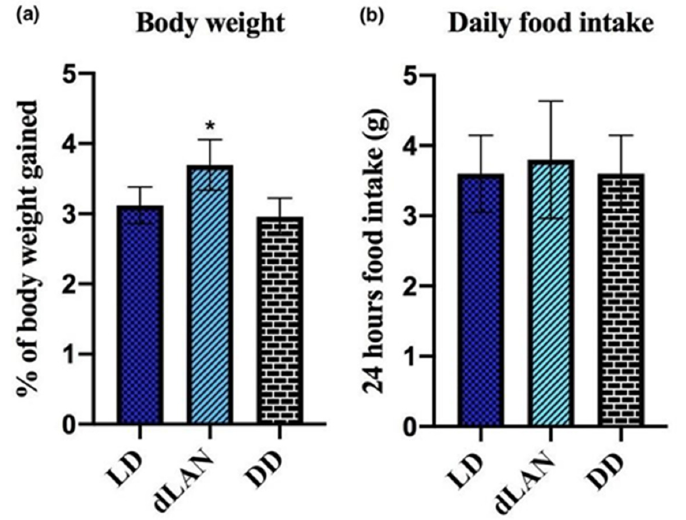
Figure 1. Effect of exposure to dim light at night (dLAN) and complete darkness (DD) on ( a ) the percentage of body weight gained and ( b ) the food intake. Values are represented as mean ± standard deviation ( n = 5). Non-parametric one-way ANOVA with Dunnett’s post-hoc test to differentiate the results between the light/dark (LD) control vs. the dLAN control and DD control. All the data were analyzed with GraphPad Prism-8 software. The statistical values * p < 0.05 represent a significant difference among the groups.